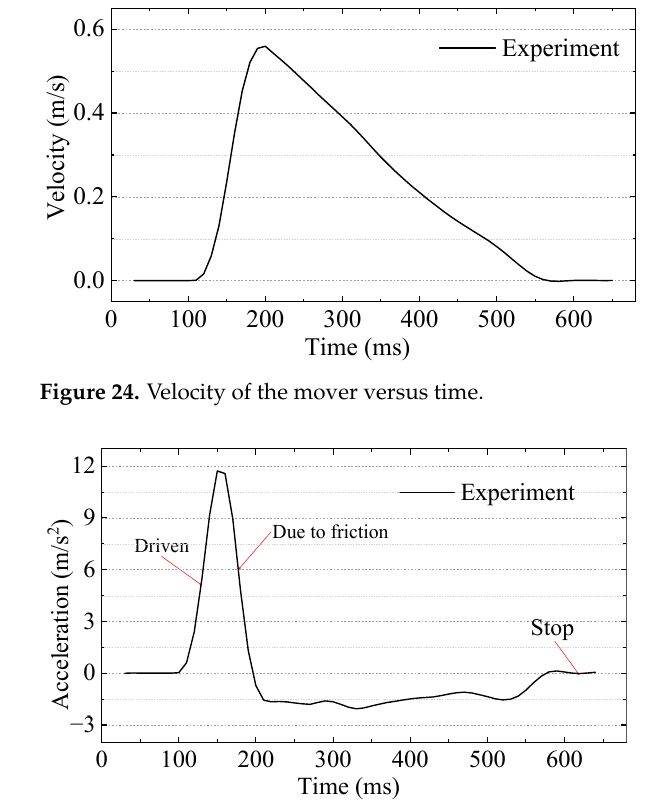
Figure 23. Position of the mover versus time.